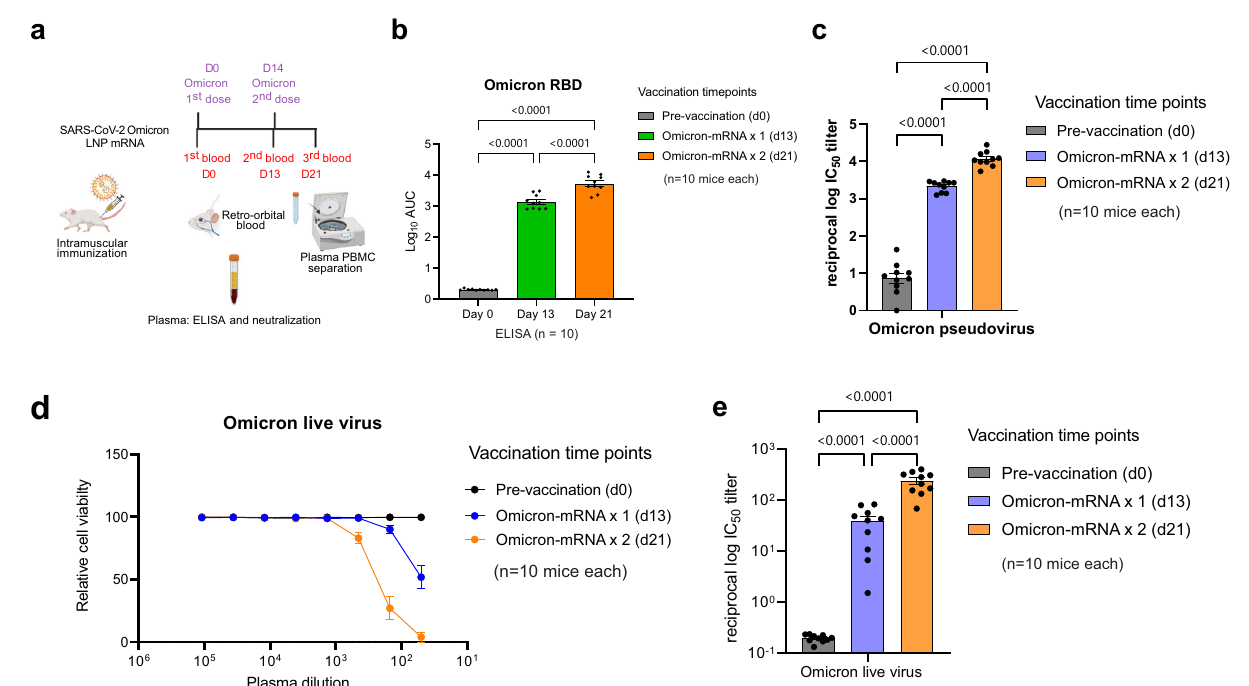
Fig. 2 Omicron-speci fi c LNP-mRNA vaccine-elicited neutralizing antibodies against SARS-CoV-2 Omicron variant. a Immunization and sample collection schedule. Retro-orbital blood was collected prior Omicron LNP-mRNA vaccination on day 0, day 13, and day 21. Ten mice ( n = 10) were intramuscularly injected with 10 µ g Omicron LNP-mRNA on day 0 (prime, Omicron × 1) and day 14 (boost, Omicron × 2). The plasma and peripheral blood mononuclear cells (PBMCs) were separated from blood for downstream assays. The slight offset of the labels re fl ects the fact that each of the blood collections were performed prior to the vaccination injections. Data were collected from two independent experiments and each experiment has fi ve mice. Created with BioRender.com. b Binding antibody titers of plasma from mice vaccinated with Omicron LNP-mRNA against Omicron spike RBD as quanti fi ed by area under curve of log 10 -transformed titration curve (Log 10 AUC) in Supplementary Fig. 1. Each dot in bar graphs represents the value of one mouse ( n = 10 mice). c Neutralization of Omicron pseudovirus by plasma from Omicron LNP-mRNA vaccinated mice. d Omicron live virus titration curves over serial dilution points of plasma from mice before and after immunization with Omicron LNP-mRNA at de fi ned time points. Data of each sample were collected from three replicates ( n = 10 mice). e Neutralization of Omicron infectious virus by plasma from Omicron LNP-mRNA vaccinated mice ( n = 10 mice). Data on dot-bar plots are shown as mean ± s.e.m. with individual data points in plots. One-way ANOVA with Dunnett ’ s multiple comparisons